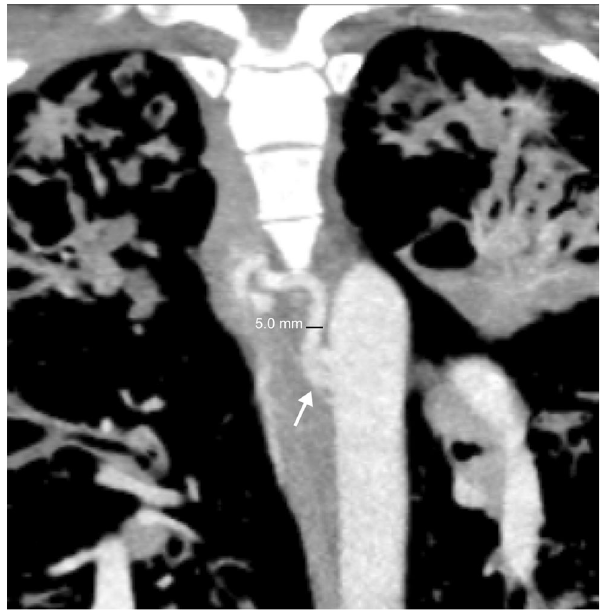
Fig. 19 Bronchial artery anatomy. Coronal CT of the chest shows a dilated rightbronchial artery (5mm)arising from the intercostal bronchial artery trunk (ICBAT) ( white arrow ) of the postero-lateral thoracic aorta at the level of T6. Please note that the normal bronchial artery is less than 2 mm in diameter. While ICBAT origin is the most typical of the right bronchial artery, the left bronchial arteries usually arise directly from the